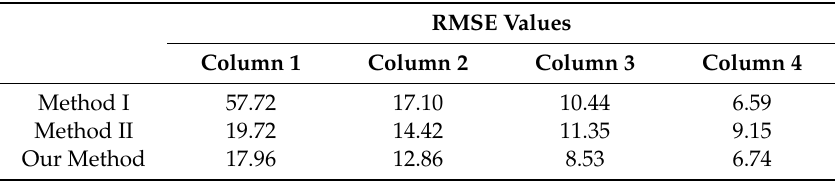
Table 3. RMSE values of coarse models (Column 1 corresponds with the first column in Figure 17 and Column 2 corresponds with the second column in Figure 17 and so